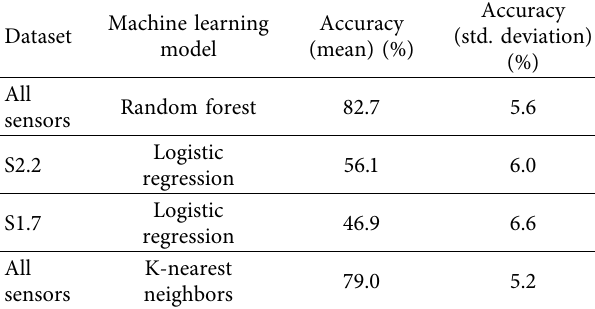
Table 7: A comparison of the accuracy of several machine learning models.